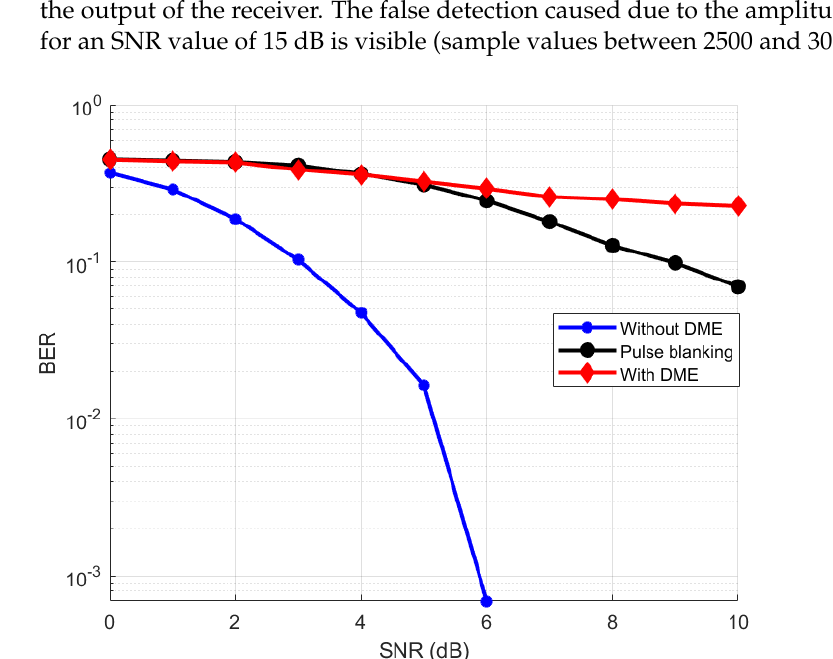
Figure 7. Performance of conventional pulse blanking technique vs. without DME interference and with DME interference.